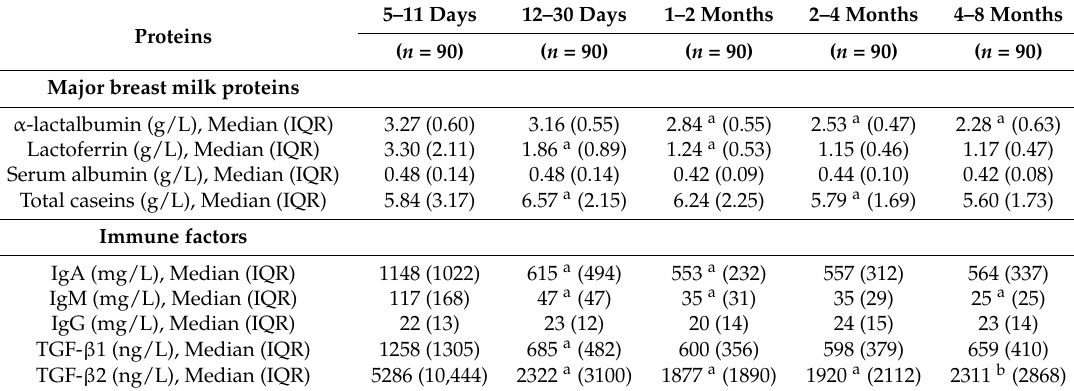
Table 2. Protein content of human breast milk from the different lactation stages (see also Figure